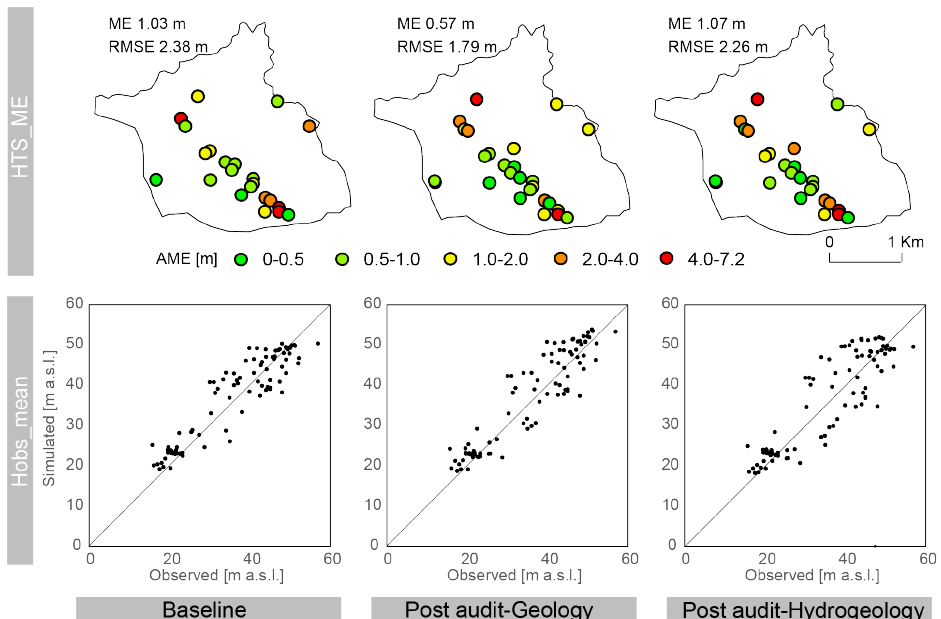
Figure 4. Spatial distribution of model precision of hydraulic heads for wells with observed time series for the Baseline model ( left ), the Post audit-Geology model ( middle ), and the Post audit-Hydrogeology model ( right ). The spatial representation ( upper maps ) is based on the HTS_ME group and shows the absolute mean error (AME), whereas the statistics are the mean error (ME) and root mean squared error (RMSE). Errors for the Hobs_mean group are illustrated in the lower scatter plots.